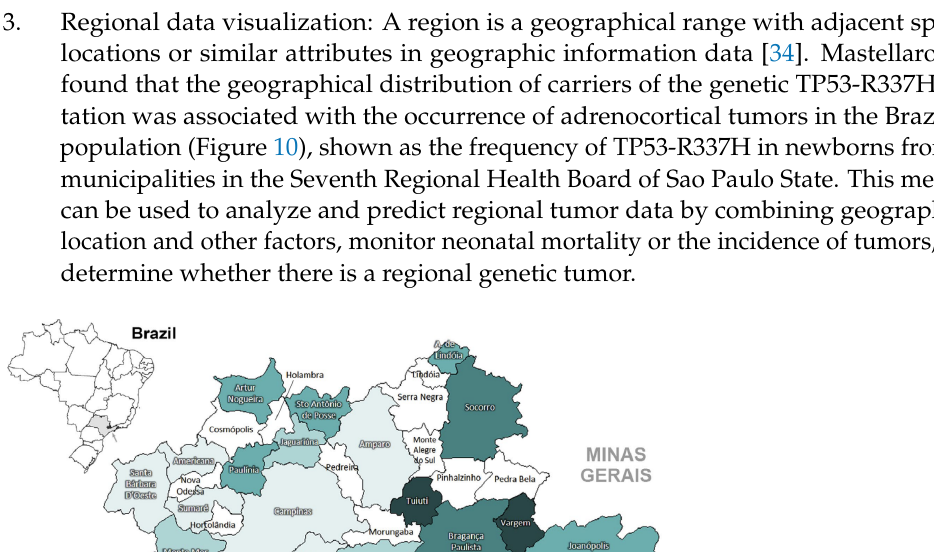
Figure 9. Line data visualization [36]. Blue colors represent places that had more out-migration than in-migration while red areas were hot destinations.